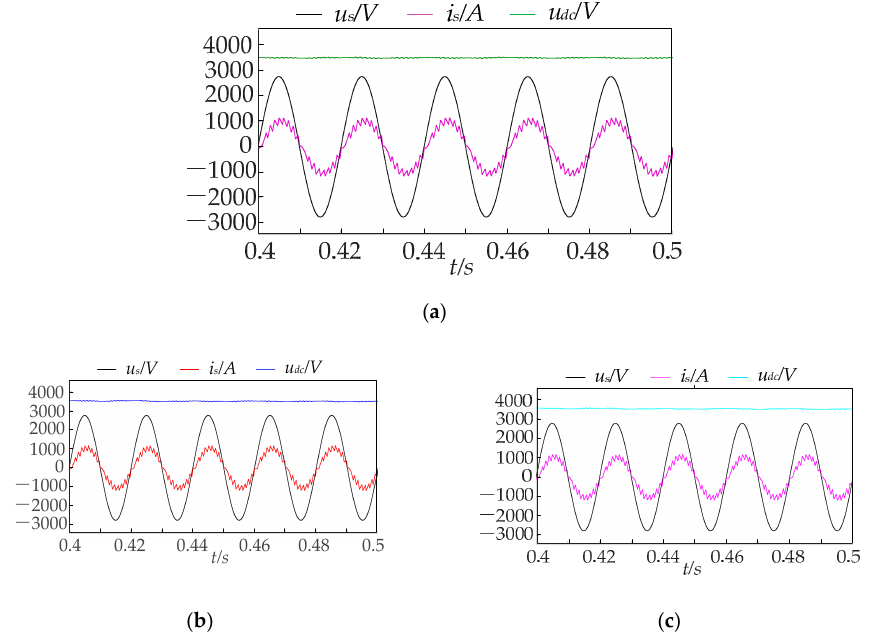
Figure 11. Steady-state waveforms: output voltage u dc , grid voltage u s and the inductor current i s under ( a ) conventional IGBT; ( b ) all period desaturation control; ( c ) desaturation control of the current threshold 10%.